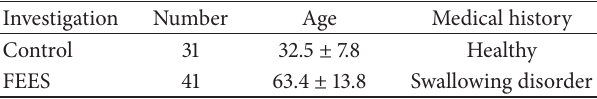
Table 1: Summary of test subjects.